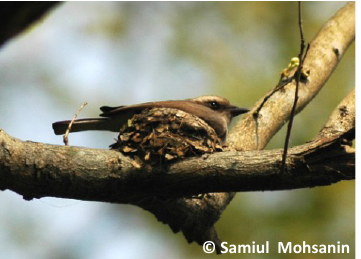
Image 16. Common Iora nest